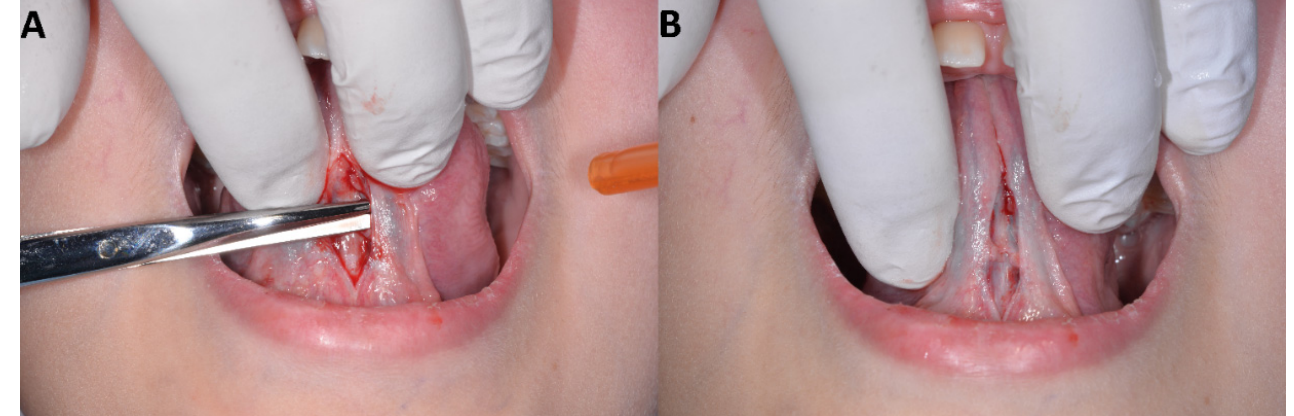
Figure 4. The mucous layer being separated from the underlying muscle layers using a scissor ( A ) and the increased mobility obtained throughout this operation ( B ).